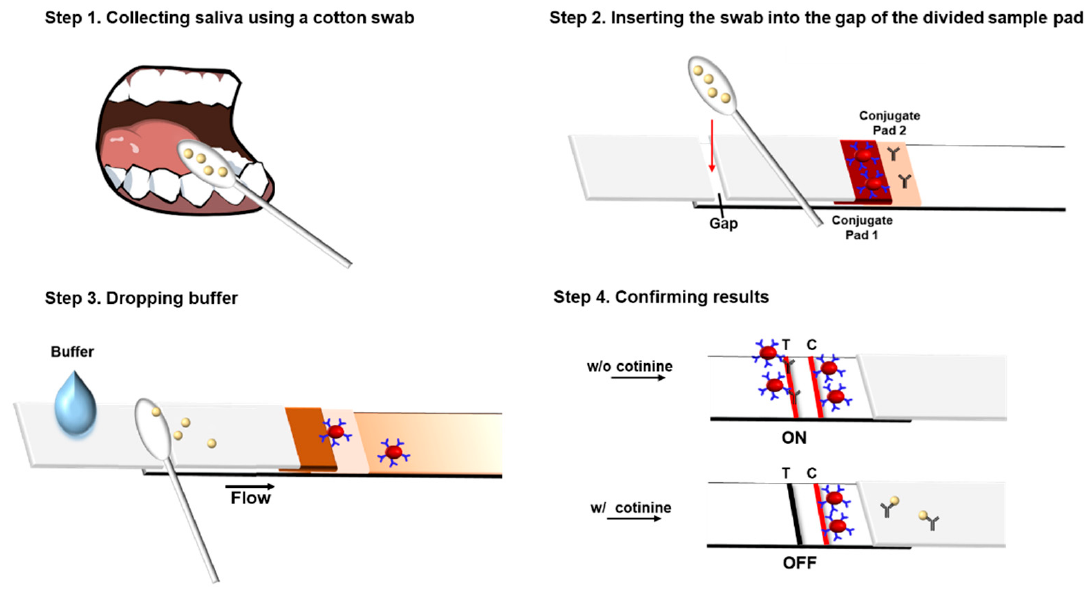
Figure 2. Procedure of the gap-LFIA system for salivary cotinine detection. C, Control line (anti-mouse IgG dried); T, Test line (cotinine-BSA dried). The intensity of test lines in Step 4 signal “on” without cotinine and “off” in the presence of cotinine.